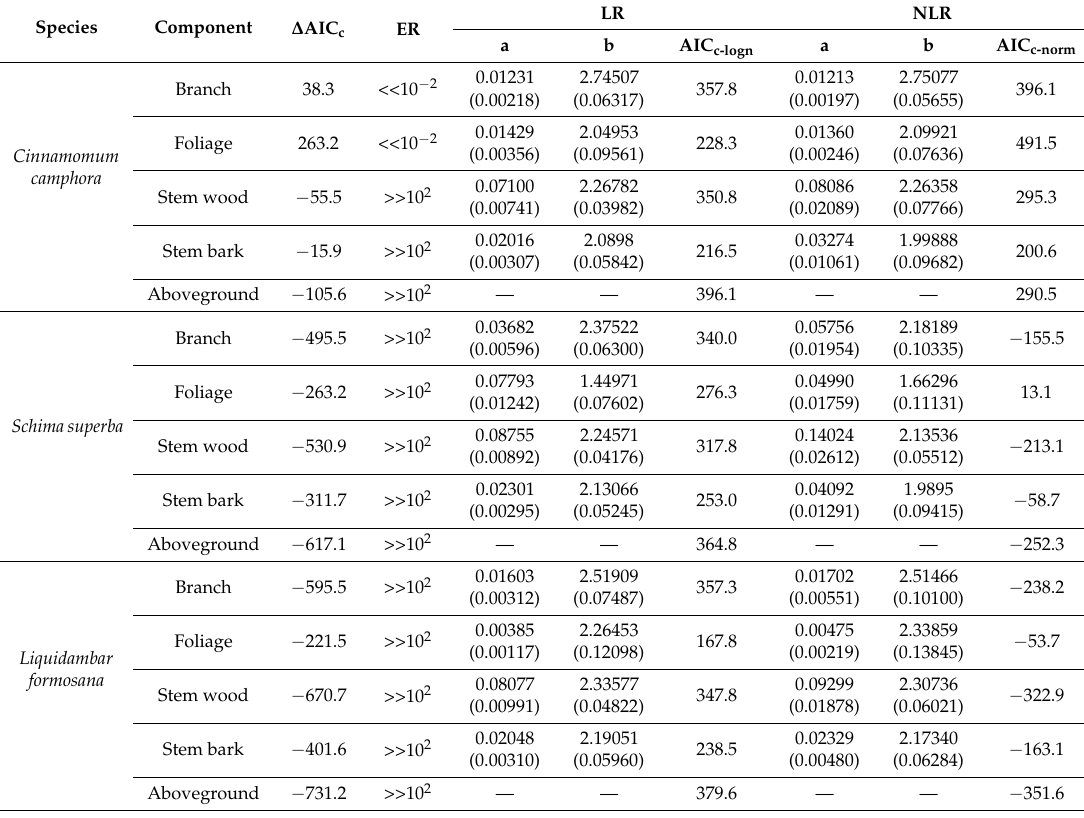
Table 2. Results of parameter estimate and likelihood analysis based on